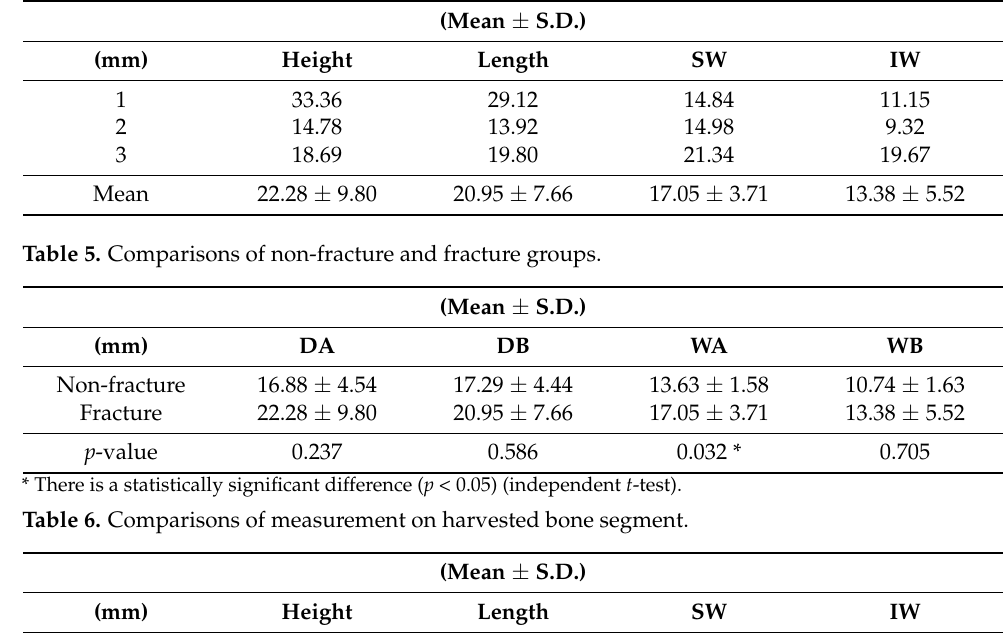
Table 4. Harvested bone segment on fractured patient.